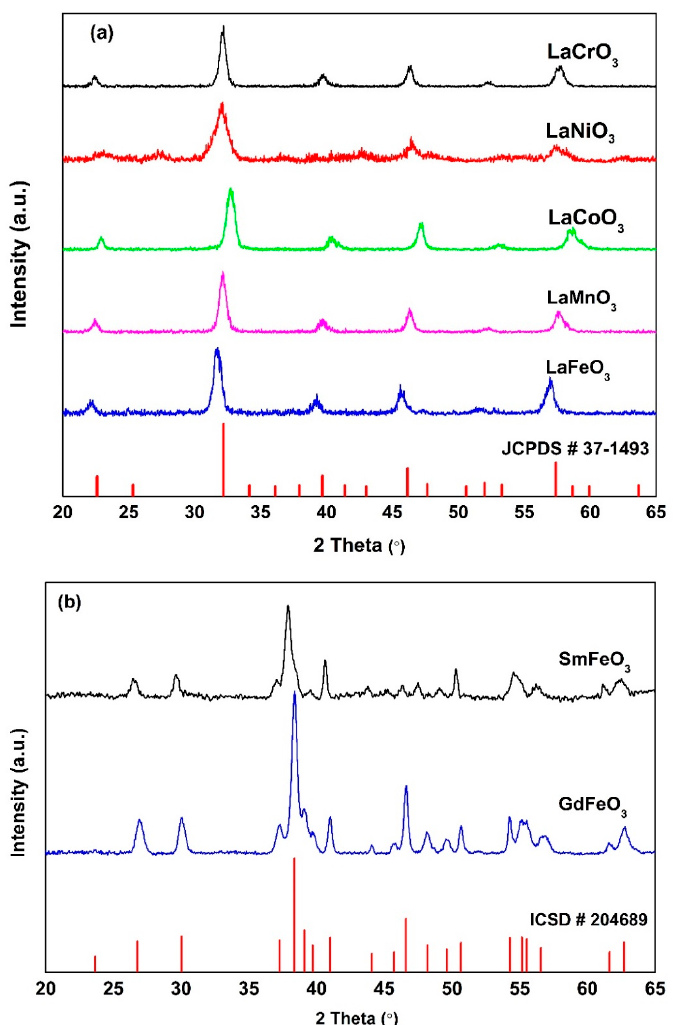
Figure 1. The XRD patterns of prepared perovskite materials using ( a ) Cu anode and ( b ) Co anode. The referenced peaks are indicated by red lines at the bottom.